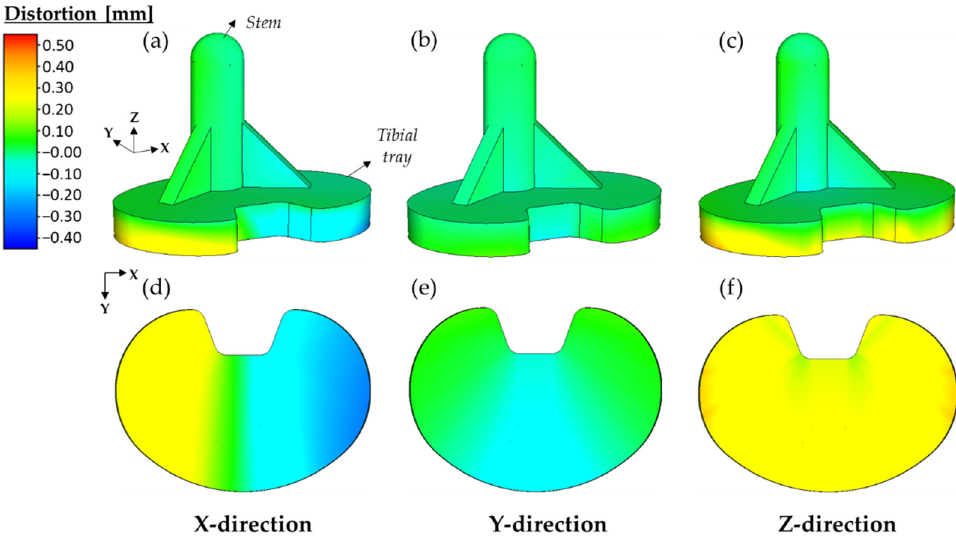
Figure 9. Distortion distribution in each direction of the as-built S-T8 tibial component. ( a , d ) X- direction; ( b , e ) Y-direction; ( c , f ) Z-direction.